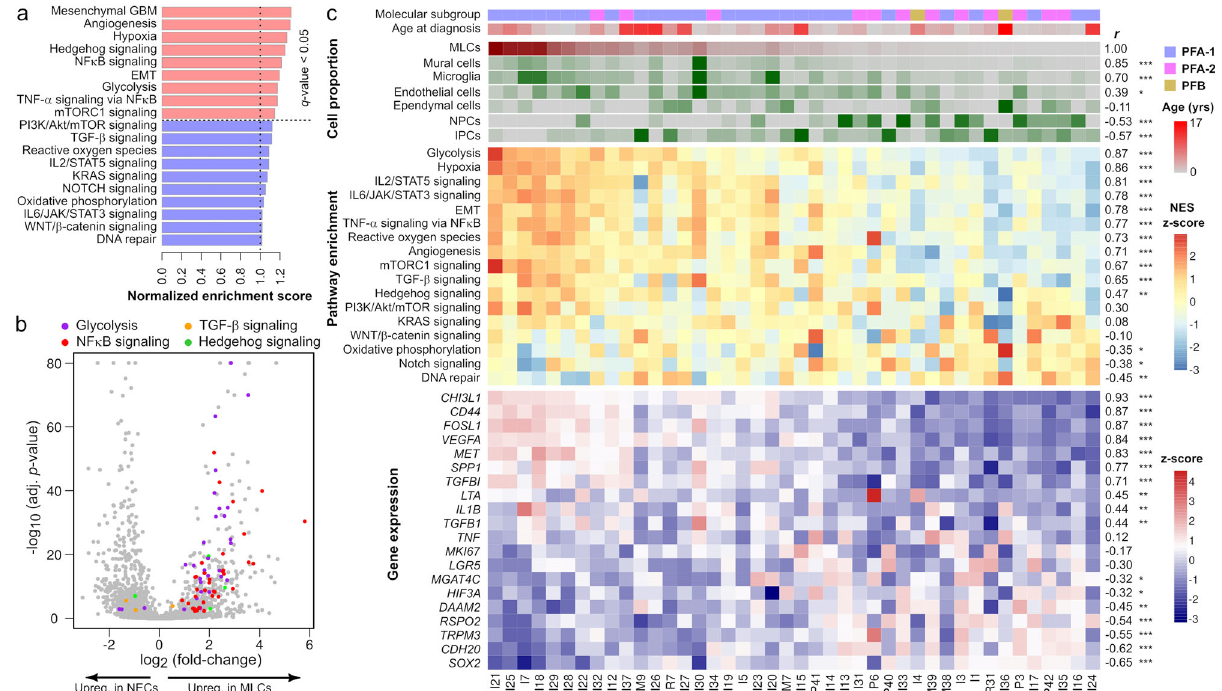
Fig. 2 The mesenchymal-like tumor cell population of posterior fossa ependymoma is associated with hypoxia, angiogenesis, glycolysis, and NF κ B signaling gene expression programs. a GSEA in the MLC population showing enrichment for hypoxia, angiogenesis, glycolysis, NF κ B, and other signaling pathways in this population. Normalized enrichment scores larger or smaller than 1 indicate an enrichment or depletion of the gene set in the MLC population, respectively. b Volcano plot showing differentially expressed genes between neuroepithelial- and mesenchymal-like tumor cells, where genes belonging to glycolysis, NF κ B signaling, TGF- β signaling, and hedgehog gene sets are indicated (Fisher ’ s method combined p value, adjusted for multiple hypothesis testing using Benjamini-Hochberg procedure). c The single-nucleus gene expression data were used to infer cell population abundances in a cohort of 42 pediatric posterior fossa ependymal tumors pro fi led with bulk RNA-seq by CBTN. Tumors are arranged from left to right by decreasing inferred abundance of MLCs. From top to bottom, the molecular subgroup, age of diagnosis, inferred abundance of distinct cell populations, GSEA scores of various representative signaling pathways, and expression of representative genes are shown. On the right side, the Spearman ’ s correlation coef fi cient of each of these features with the inferred abundance of MLCs and its level of signi fi cance are indicated (two-sided test of association; *FDR (cid:3) 0 : 05, **FDR